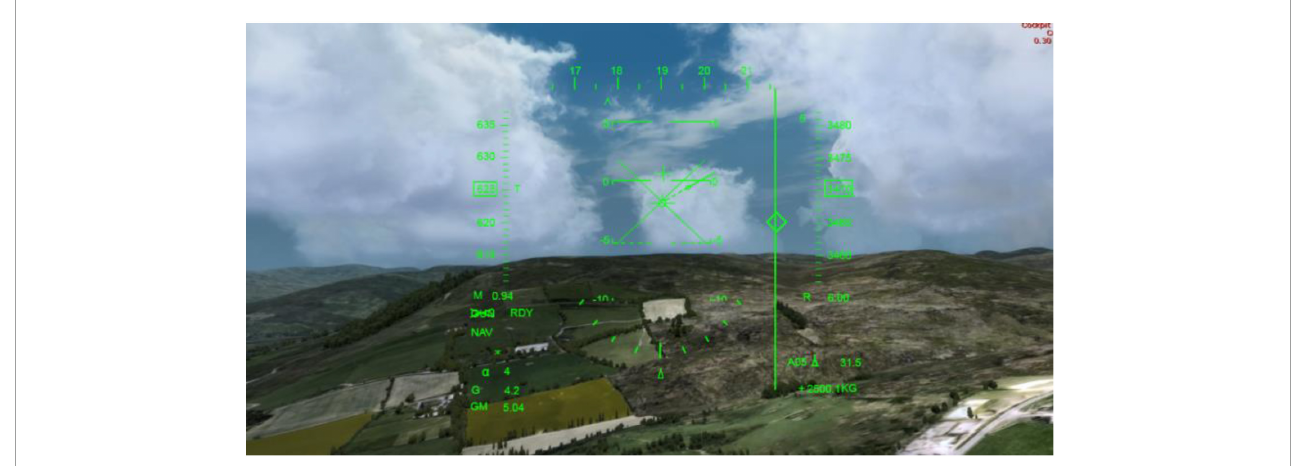
FIGURE3 Screenshot of dynamic flight scene videos.